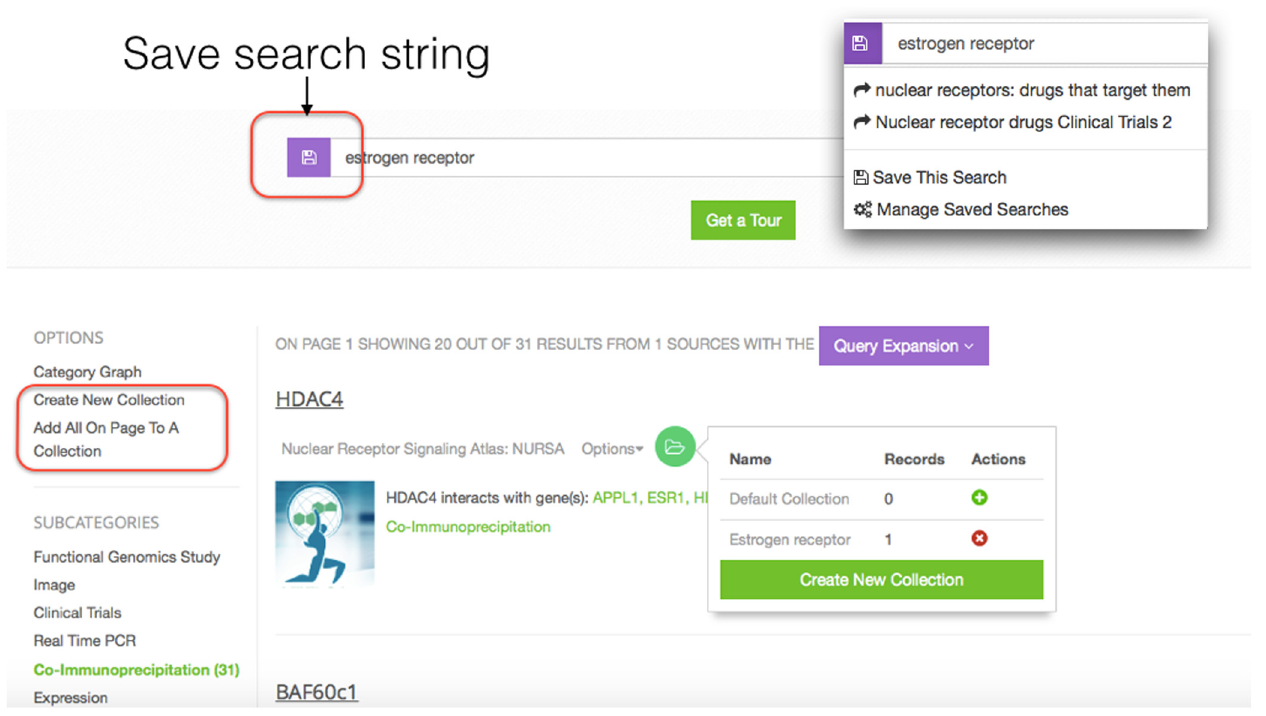
Fig 6. Collections and Save Searches Users can create collections to store data records. A record can be added to one or more collections. All records on a page can be added to a collection by selecting the “ Add all records ... ” option in the left navigation menu. Searches are saved by selecting the icon to the left of the search bar. A menu is then displayed (inset, upper right) that shows previously saved searches, along with functions to save the current